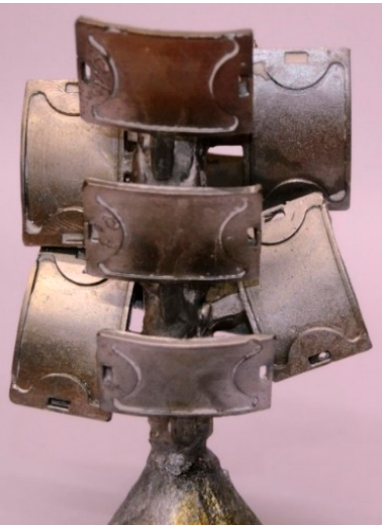
Figure 14. An example of the application of PE-wax modified by bentonite for the production of an aluminum alloy casting in the lost-wax casting